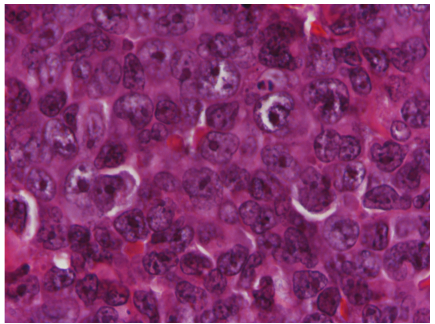
Figure 3: Pathology image.